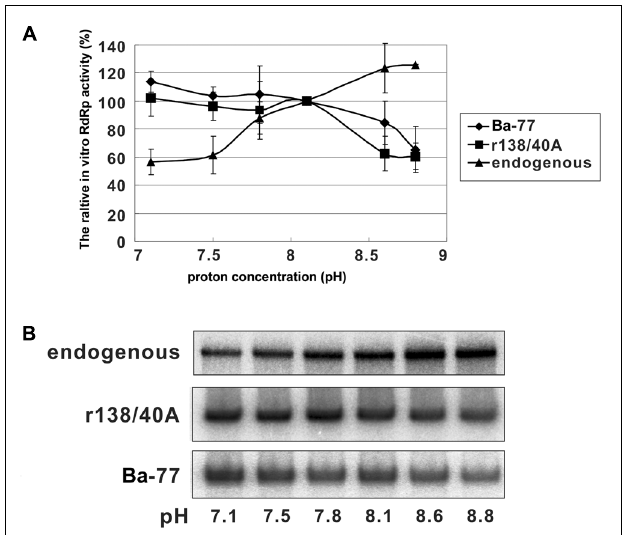
FIGURE 6 | In vitro replication assay with the RNA templates in various pH conditions. (A) The relative RdRp activity of in vitro replication assay with endogenous and exogenous templates as indicated. The RdRp activity with pH 8.1 was set to 100%. Each point on the graph is the mean relative RdRp activity with the standard errors derived from three independent experiments. (B) Representative results of the in vitro replication